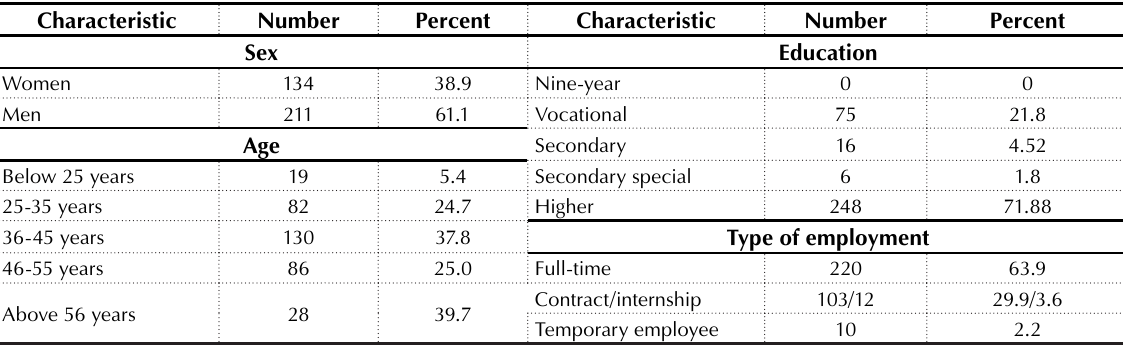
Source: Calculated by the